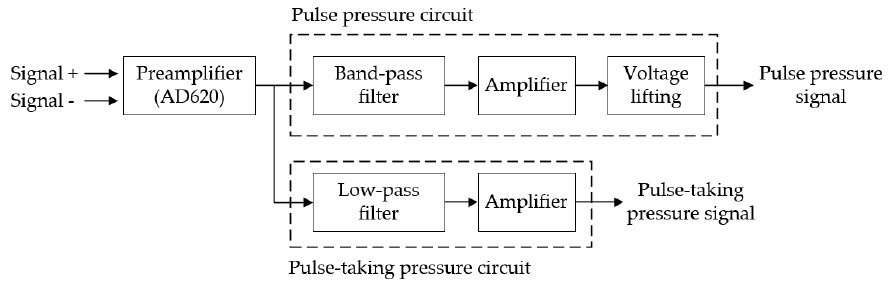
Figure 4. Schematic diagram of signal processing circuit.